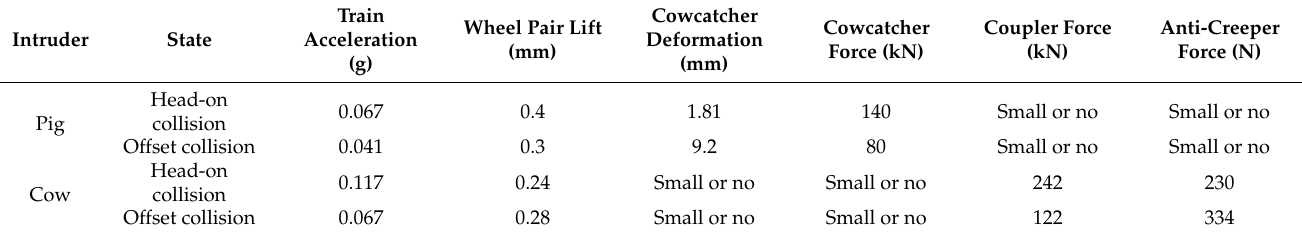
Table 9. Crash simulation data summary